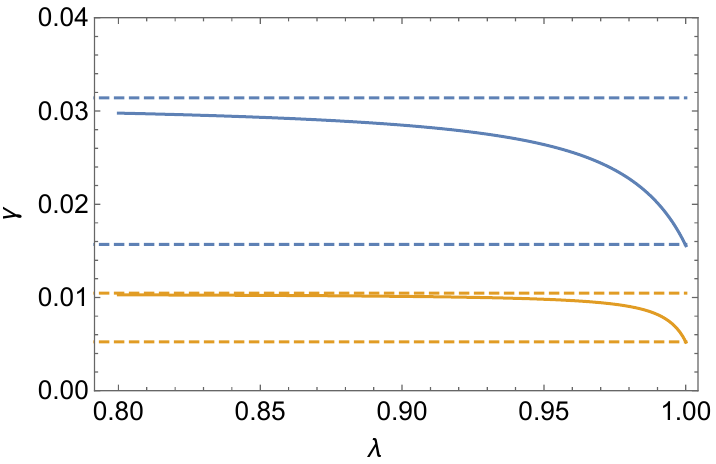
Figure 8 . Here we show γ as a function of λ for β J = 200 and β J = 800 in blue and orange respectively. We also show in dashed lines the upper and lower bounds on γ obtained analytically (in a 1 /β J expansion.) Note that for larger β J , γ quickly obtains its maximal value 2 π/β away from λ = 1